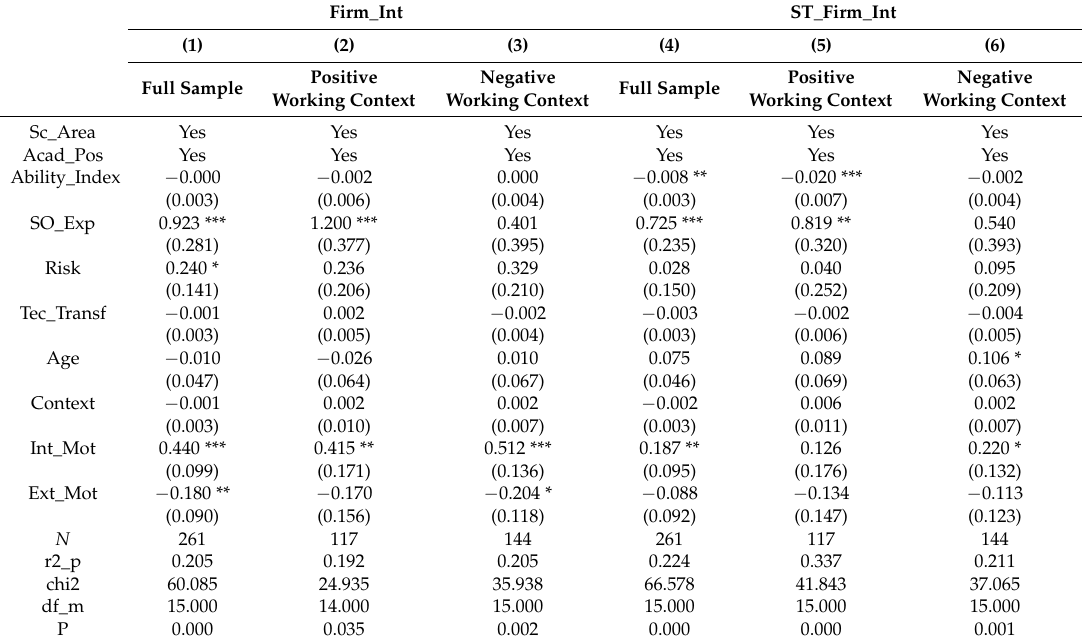
Table 8. Probit results (Marginal effects